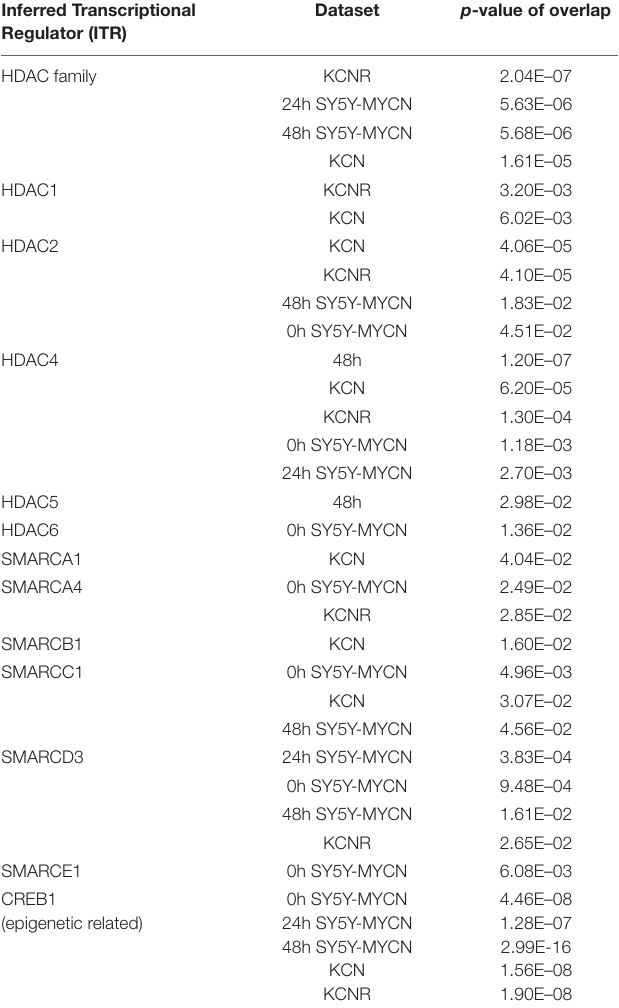
TABLE 2 | Inferred Transcriptional Regulators (ITRs) for MYCN ChIP-seq samples belong to HDAC and SMARC families of epigenetic regulators. Inferred Transcriptional Dataset p -value of Regulator (ITR)